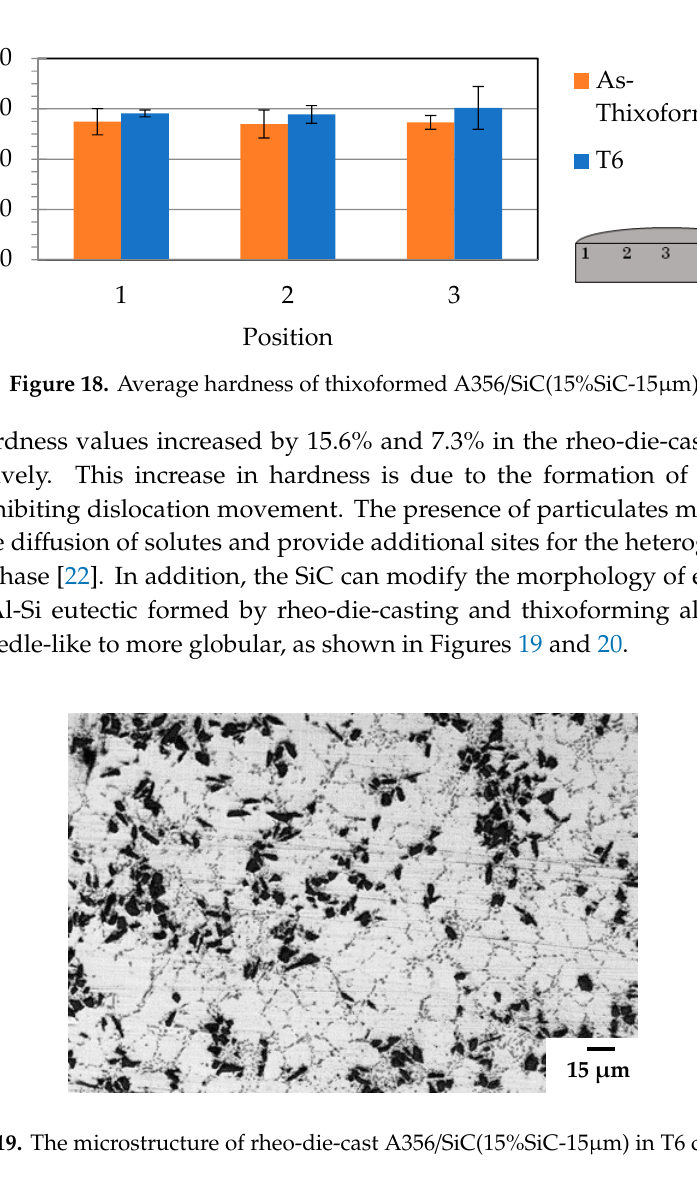
Figure 17. Average hardness of rheo - die-cast A356 / SiC(15%SiC - 15µm) of position 1 and 6 .